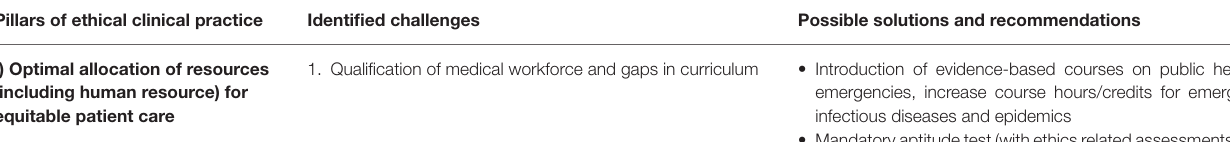
TABLE 2 | Major ethical dilemmas/challenges experienced by healthcare professionals in decision-making process during COVID-19